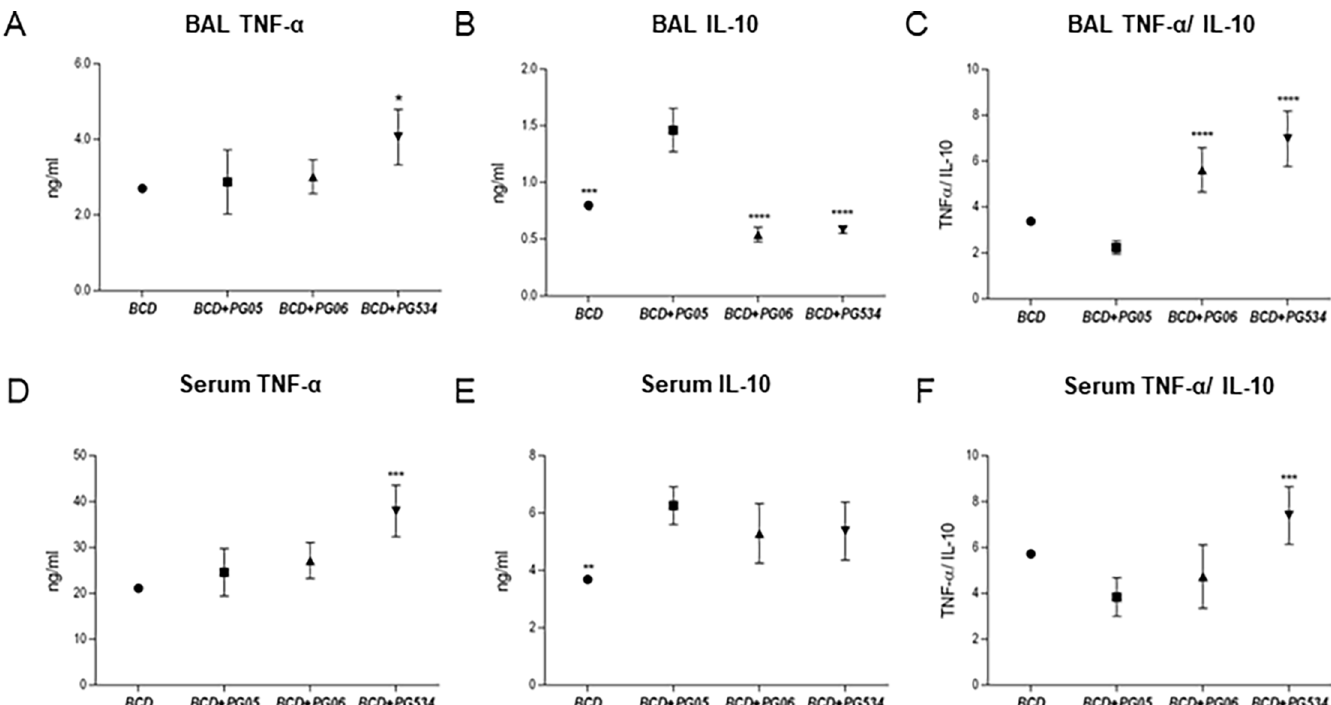
Fig 4. Effect of lactobacilli peptidoglycans on TNF- α and IL-10 production after Streptococcuspneumoniae infection in malnourished mice. Immunocompromised-malnourished mice were replete for 7 days with a balanced conventional diet (BCD) or BCD supplemented with peptidoglycans from Lactobacillus rhamnosus CRL1505 (BCD+PG05), L . plantarum CRL1506 (BCD+PG06) or L . rhamnosus CRL534 (BCD+PG534), and then challenged with S . pneumoniae . The levels of cytokines were studied two days after the pneumococcal challenge. (A) TNF- α , (B) IL-10, and (C) TNF- α /IL-10 ratio in broncho-alveolar lavages (BAL). (D) TNF- α , (E) IL-10, and (F) TNF- α /IL-10 ratio in serum. Results are expressed as mean ± SD. Asterisks represent statistical differences compared with BCD+PG05 group. (cid:3) p < 0.05, (cid:3)(cid:3) p < 0.005, (cid:3)(cid:3)(cid:3) / (cid:3)(cid:3)(cid:3)(cid:3) p (cid:20) 0.001.